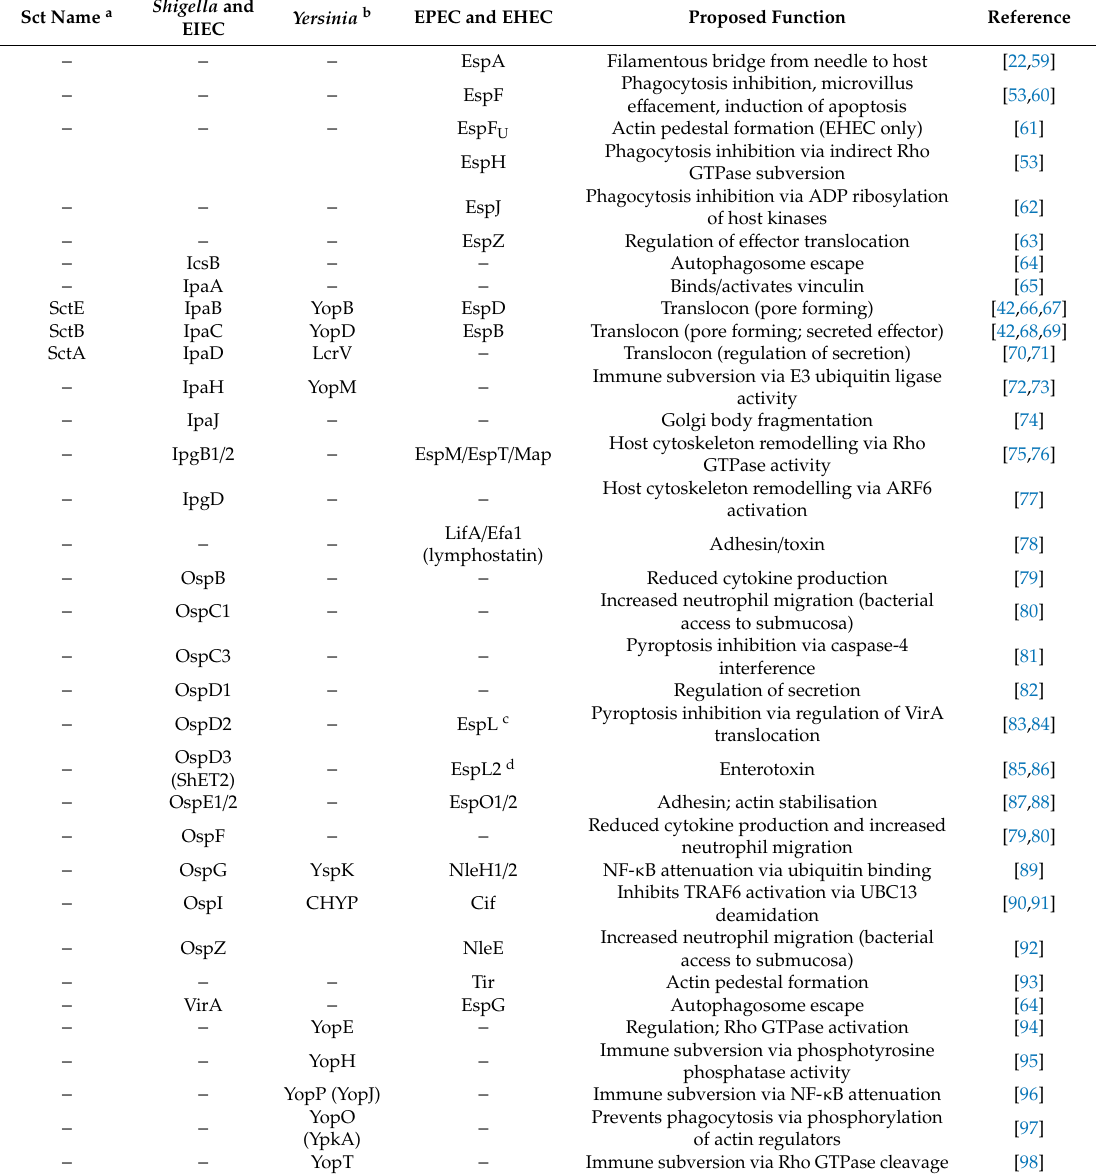
Table 1. Type 3 secretion system (T3SS) e ff ector protein